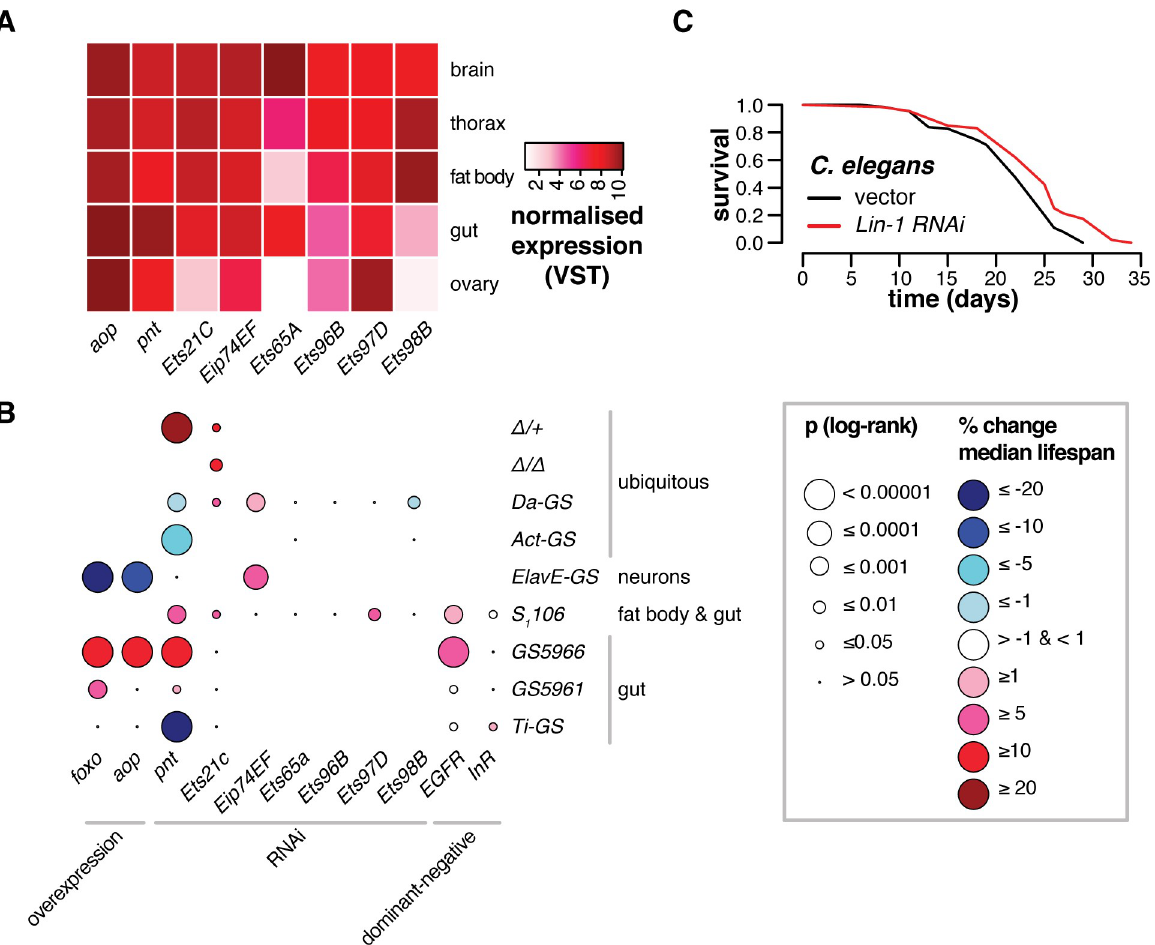
Fig 6. Lifespan regulation is a conserved function of ETS TFs. (A) The diversity and tissue-specific expression of ETS TFs in Drosophila . A variance-stabilising transformation was applied to published expression data from the same population of flies and same media as used in Figs 1–5 [5], and medians were calculated. (B) Tissue-specific lifespan regulation is a conserved function of ETS TFs in Drosophila . Plot summarises 44 lifespan experiments. Bubbles are colour-coded for percentage change in median lifespan, either in mutants relative to controls, or upon feeding RU 486 to flies bearing the indicated geneswitch drivers along with either RNAi or overexpression constructs. Bubble size represents p-values from log-rank tests. Full genotype information and p-values are given in S1 Supplementary Information. Note that lifespans of S 1 06 flies overexpressing dominant-negative InR were significantly extended due to delayed mortality in early or late portions of survival curves, despite absence of differential median survival (See S8 Fig). (C) ETS TFs have evolutionarily-conserved functions in lifespan: Feeding lin-1 RNAi to the nematode C . elegans from egg promotes longevity (log-rank test p =